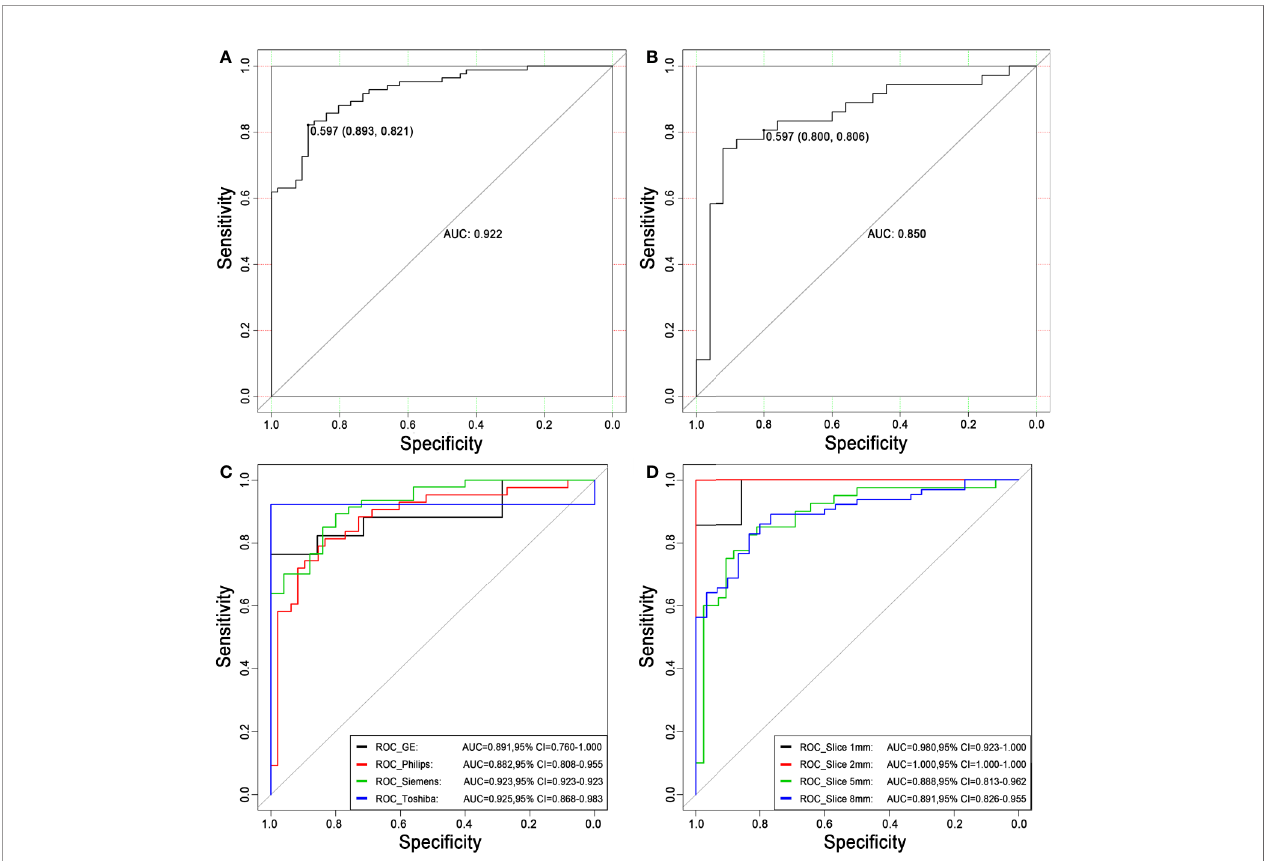
FIGURE 5 | Receiver operating characteristic curves for distinguishing malignancy and benignity using the logistic regression model. (A) The ROC curve of the training set. The AUC was 0.922. Based on the maximum Youden index, the best threshold of the decision score was determined to be 0.597 in the training set, and the corresponding speci fi city and sensitivity were 0.893 and 0.821, respectively. (B) The ROC curve of the test set. The AUC was 0.850. When the best threshold of 0.597 of the training set was applied to the test set, the corresponding speci fi city and sensitivity were 0.800 and 0.806, respectively. (C) The ROC curves of different scanners. (D) The ROC curves of different slice thicknesses. ROC, receiver operating characteristic; AUC, area under the ROC curve; 95% CI, 95% con fi dence